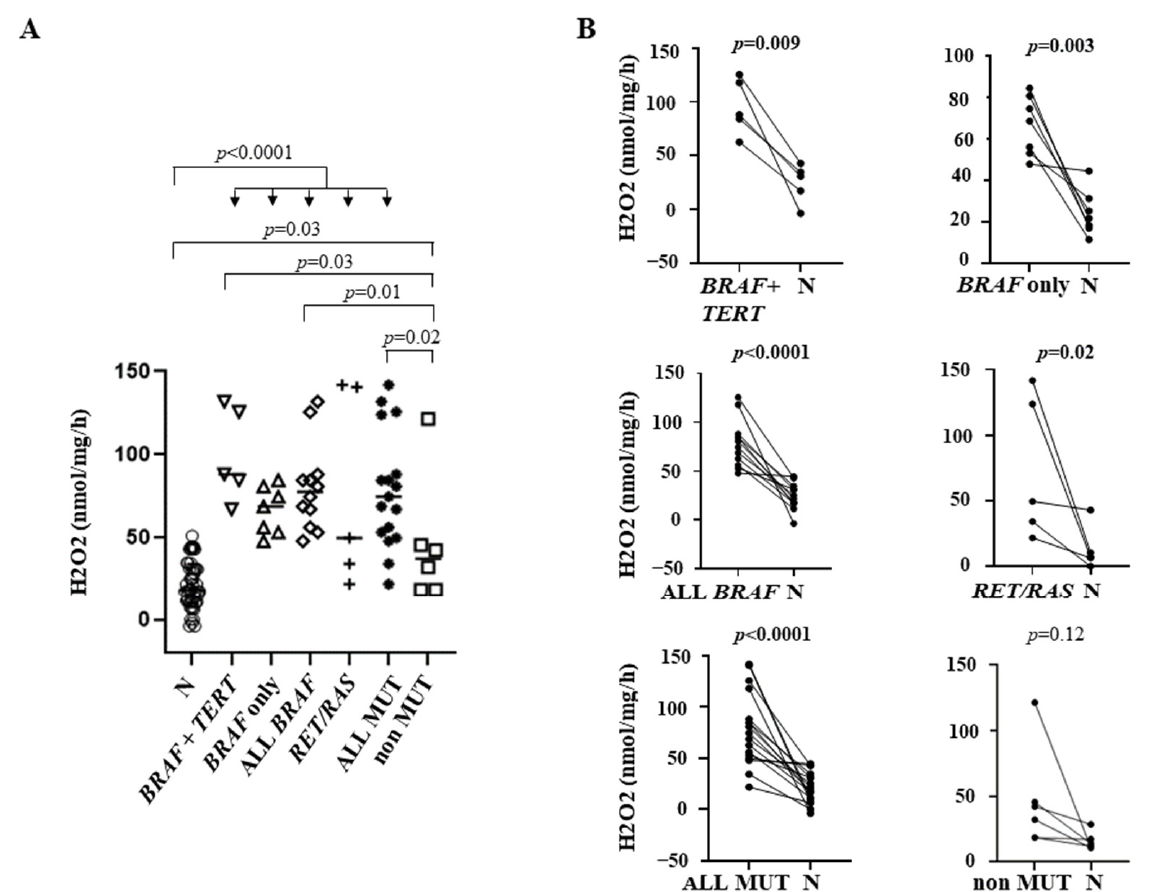
Figure 2. ( A ) H 2 O 2 generation in papillary thyroid cancers (PTCs) and contralateral tissues, according to the mutational status. The median value was plotted. ( B ) Paired analysis of H 2 O 2 generation in tumors and corresponding normal tissues. N = normal contralateral tissue; BRAF + TERT = PTC with double BRAF and TERT mutation; BRAF only = PTC with only a BRAF mutation; ALL BRAF = PTC with BRAF mutation alone or in combination; RET/RAS = PTC with RET fusions or RAS mutations; ALL MUT = PTCs with any mutation; non MUT = PTCs without mutations detected (see Methods section).